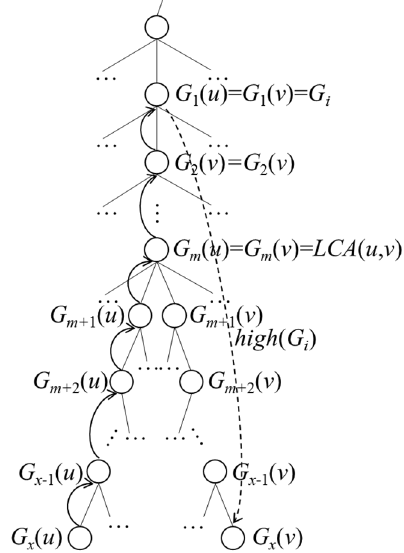
Figure 9. Case 2 of highDist ( G i , u ).